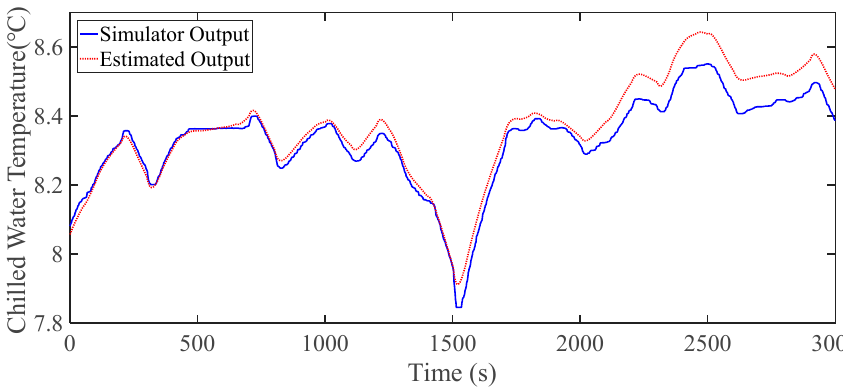
Figure 9. Estimated output and true output (cooling system).